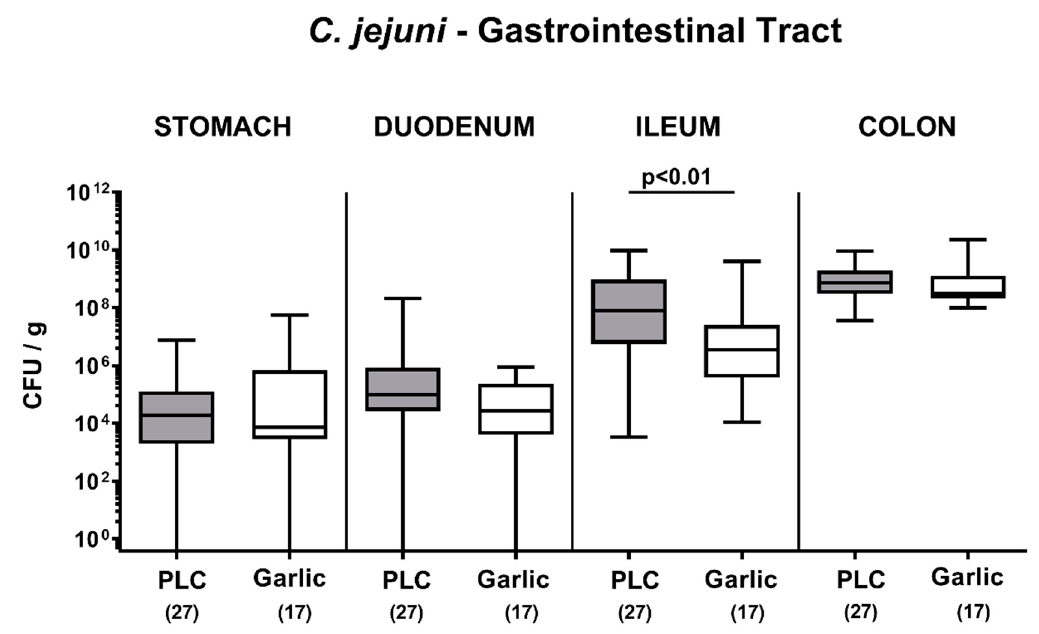
Figure 1. Pathogenic colonization of the gastrointestinal tract upon garlic essential oil treatment of C. jejuni infected IL-10 -/- mice. Secondary abiotic IL-10 -/- mice were orally challenged with C. jejuni strain 81-176 on days 0 and 1 followed by treatment with either garlic essential oil (white boxes) or placebo (PLC, gray boxes) via the drinking water starting on day 2 post-infection. On day 6 post-infection, C. jejuni was quantitated in defined gastrointestinal luminal samples by culture (colony forming units per gram; CFU/g). Box plots (indicating the 25th and the 75th percentiles), whiskers (indicating maximum and minimum values), medians (black bar inside box), significance levels ( p values) determined by the Mann- Whitney U test and the total number of mice (in parentheses) are shown (pooled data from four independent experiments).